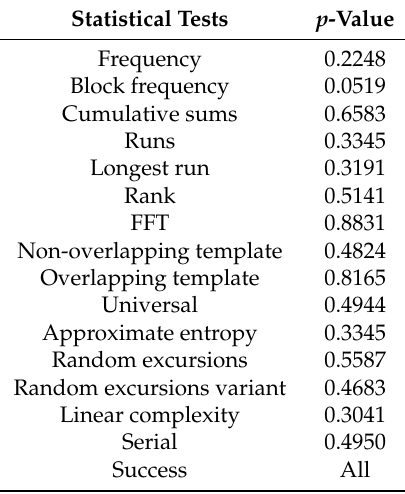
Table 3. The results of the NIST